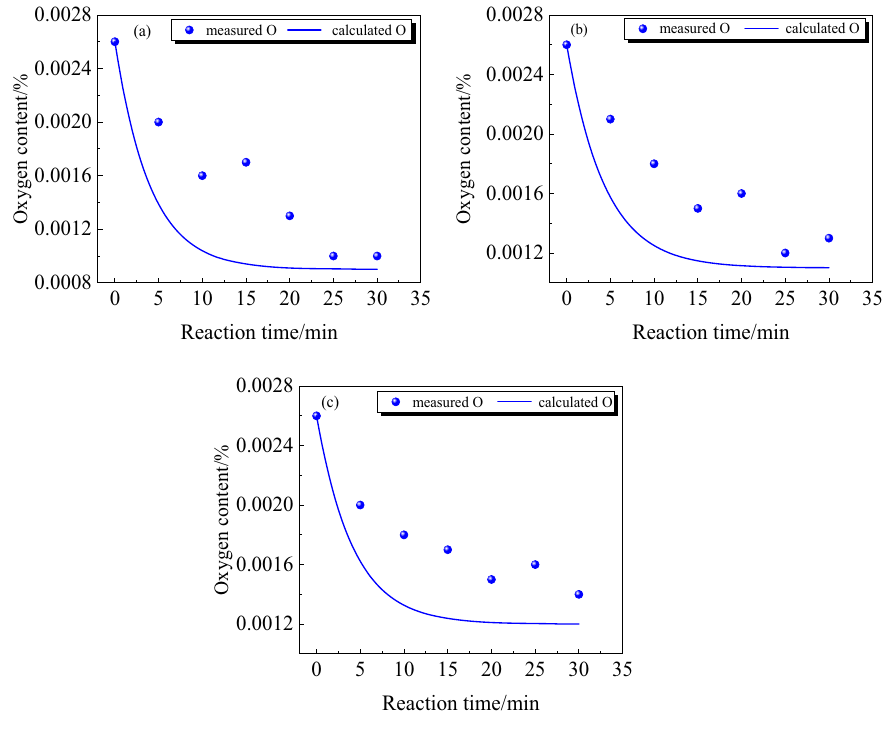
Figure 5: Changes of oxygen content in alloys: ( a ) N1, ( b ) N2, and ( c ) N3.